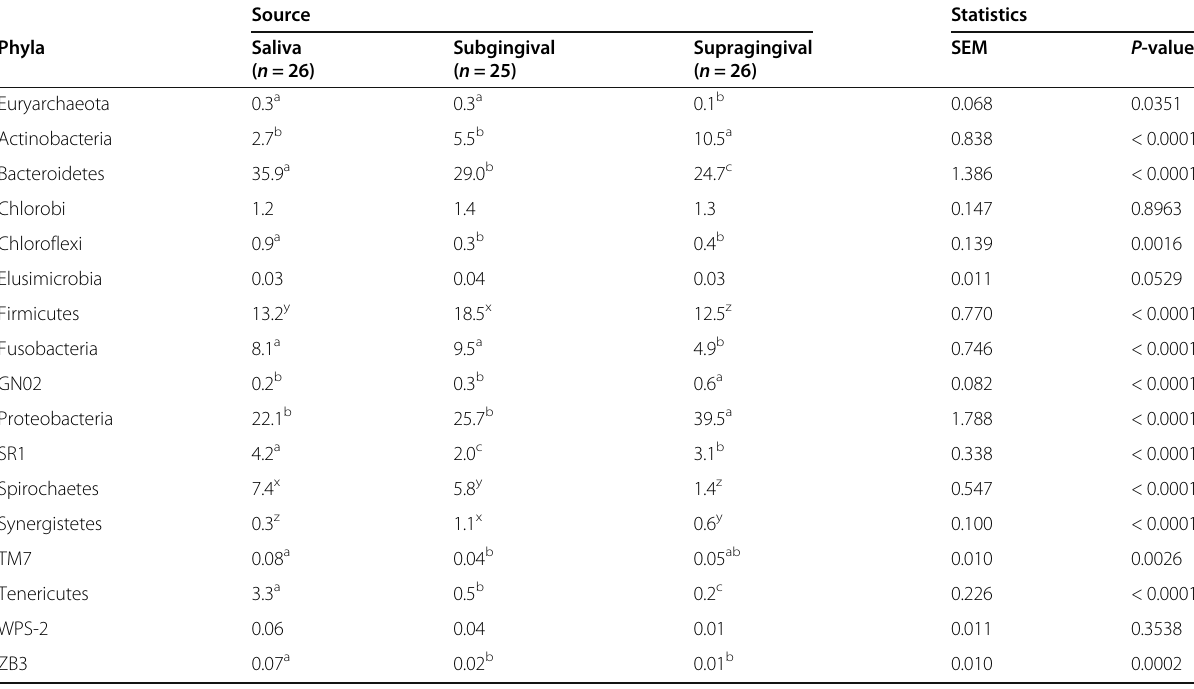
Table 2 Oral bacterial phyla (relative abundance, %) present in plaque (supragingival and subgingival plaque) and saliva samples from healthy adult dogs Source